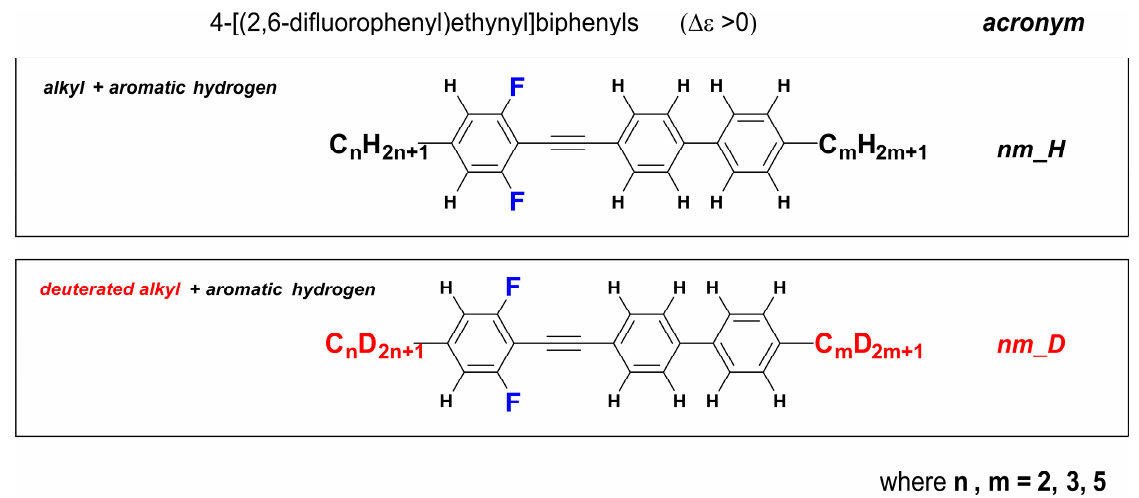
Figure 1. General structures of investigated materials.